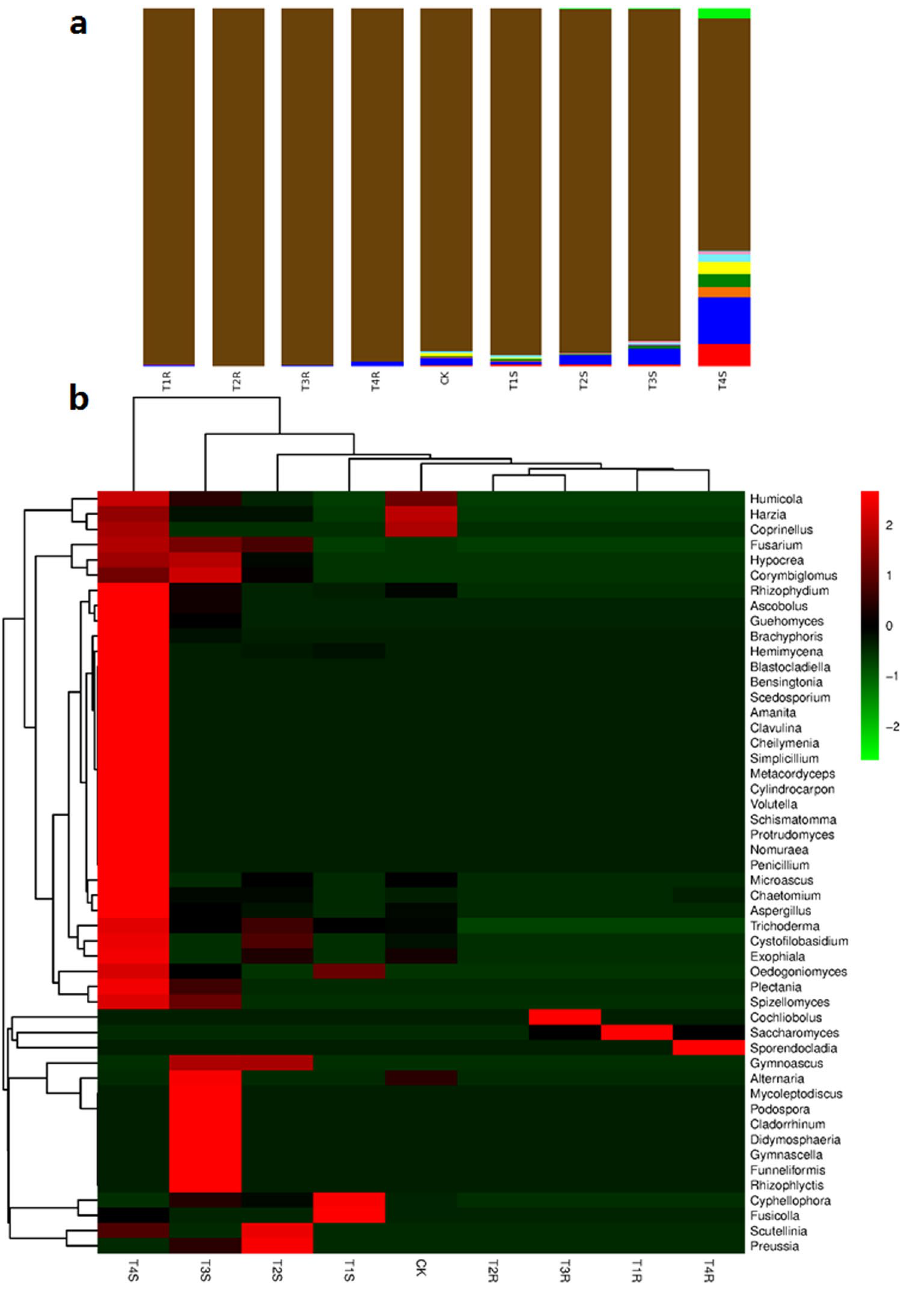
Figure 5. Analysis of fungal OTUs ( a ) Taxonomical distribution of fungal OTUs, ( b ) Heatmap analysis of OTUs of fungal species based on the Bray- Curtis similarity of 454